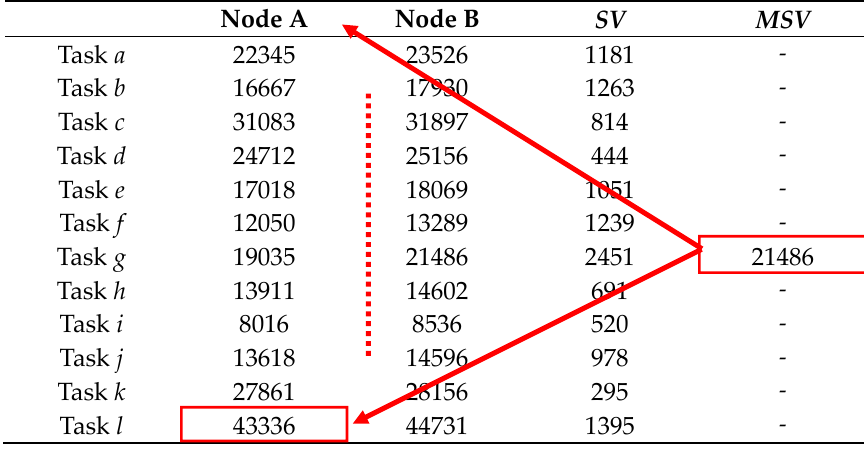
Table 9. Comparison of the average ECT values of tasks in Node A under Case 2.